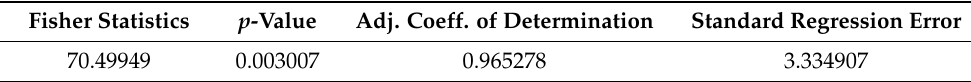
Table 15. Results of Fisher